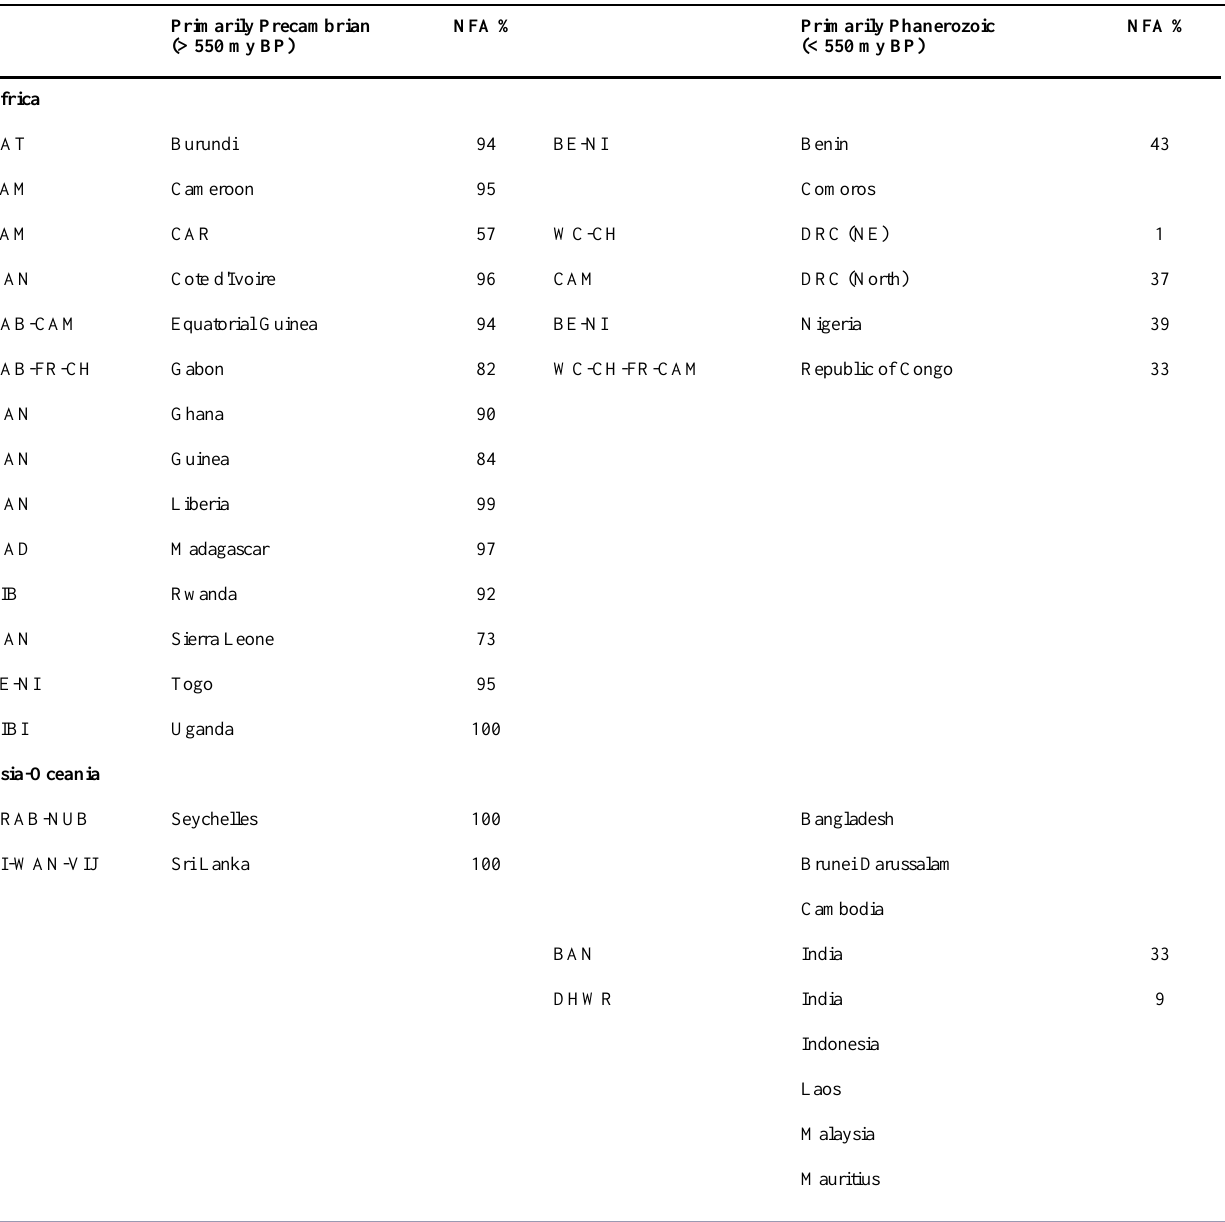
Table 2. Major global tropical forest areas by country and according to predominant age of underlying geology. Precambrian provinces assigned to forest area in each country given in left column (sensu Goodwin 1996). NFA stands for estimated percentage of national tropical broadleaved forestland area atop Precambrian terranes. See Methods for further coverage details. ARAB-NUB: Arabian-Nubian